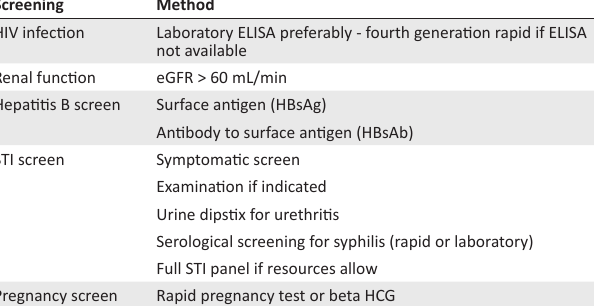
TABLE 1: Mandatory baseline investigations for pre-exposure prophylaxis initiation.